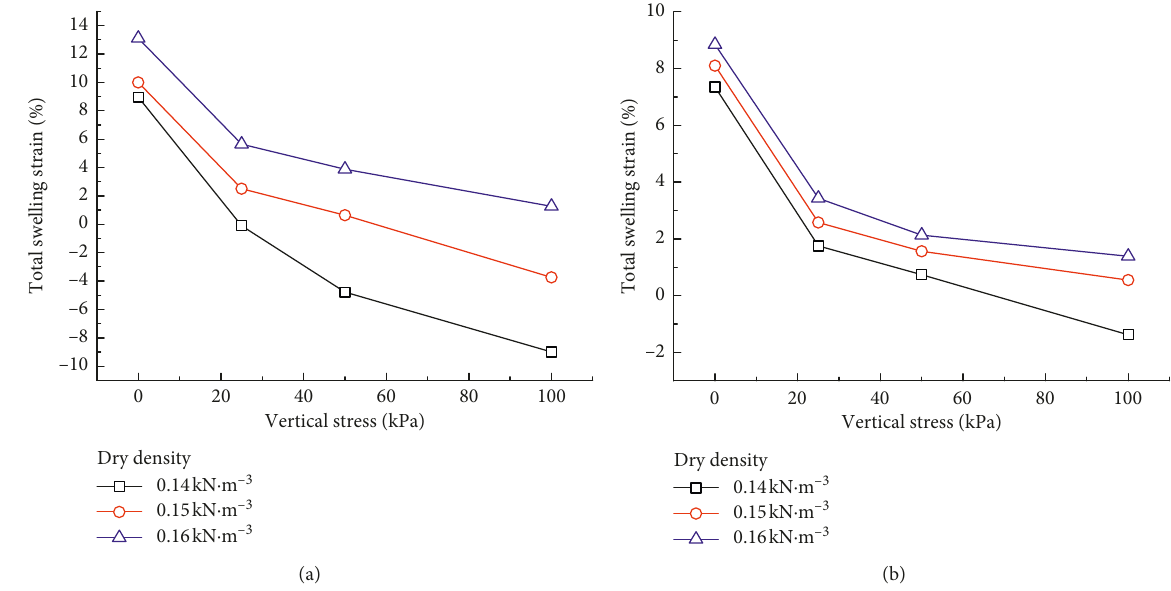
Figure 12: Relation between the swelling strain and vertical stress for different initial water contents. (a) Initial water content of 10.10%. (b) Initial water content of